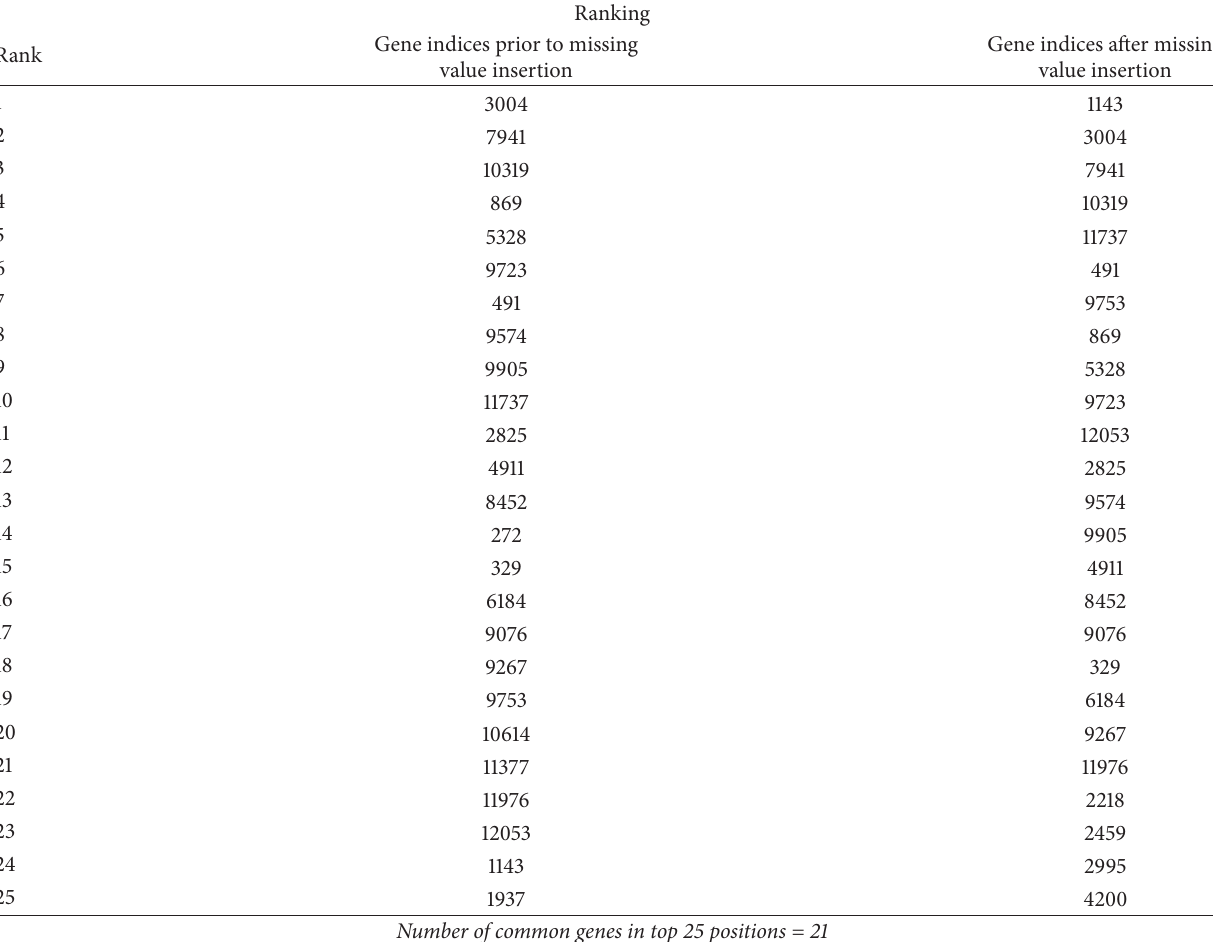
Table 9: Top 25 gene indices before and after estimation for Breast Cancer dataset.